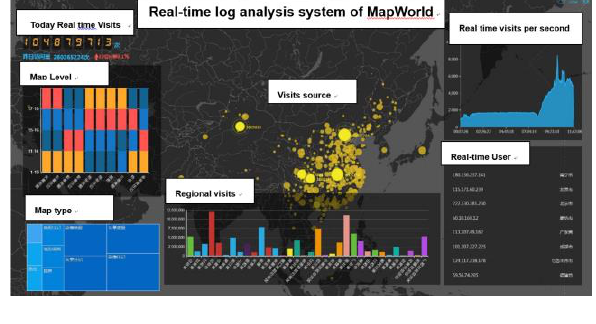
Figure 4. Big scene of the system